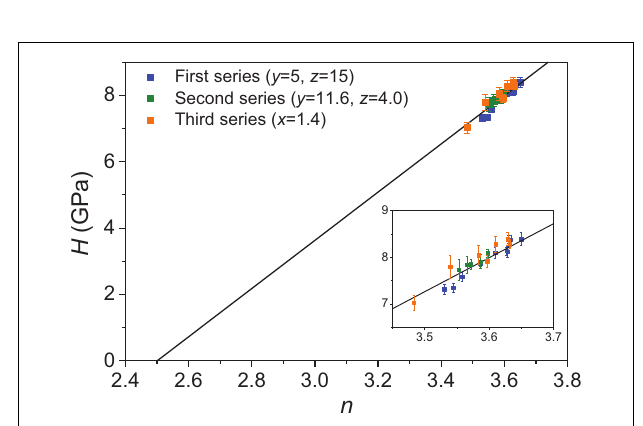
FIGURE 3 | Composition dependence ofVickers hardness ( H ) for the third series of boroaluminosilicate glasses: 83.0 SiO 2 − 1.4Al 2 O 3 − y B 2 O 3 − (15.6 − y ) Na 2 O with y = 0, 2.3, 4.8, 7.1, 8.6, 10.1, and 11.6 .The filled squares represent the experimental data points, whereas the open squares represent the computed H ( y ) values with Eq. 1 ( dH / dn = 7.4GPa) using the analyzed compositions and 11 B and 27 Al MAS NMR data (Smedskjaer et al., 2014).